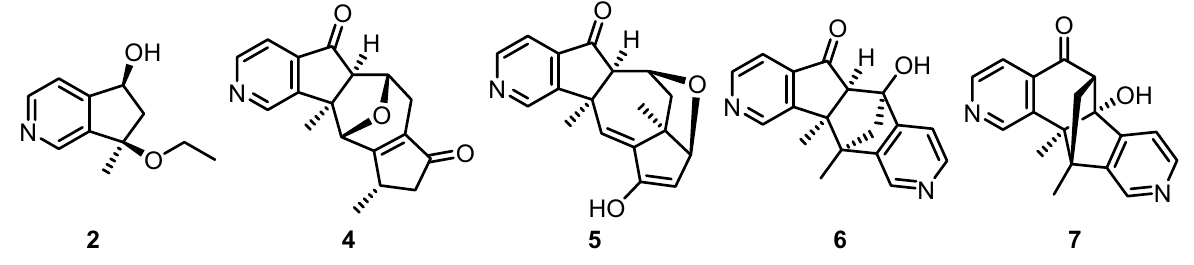
Figure 6. New compounds obtained from the aerial parts of C.